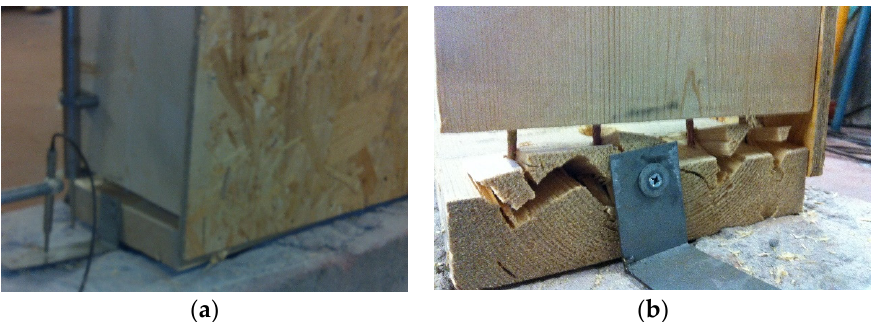
Figure 9. Specimen P: ( a ) Deformation of the sample and; ( b ) Rotation failure.